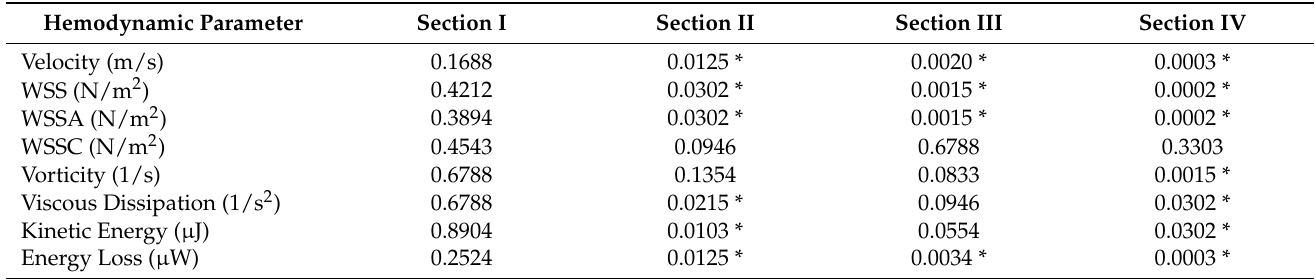
Table 3. The Wilcoxon signed-rank test p -values for the mean values of the hemodynamic parameters at each section of the vessel, between the self-gated and non-gated data.